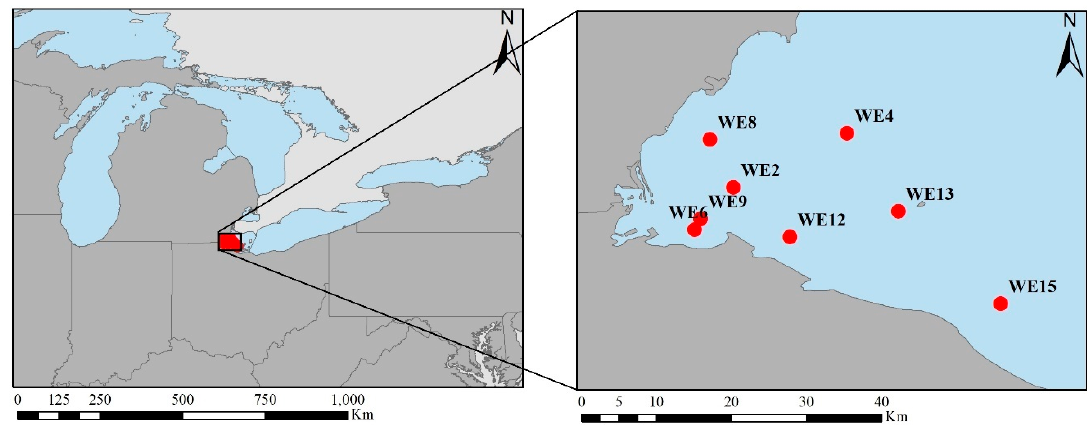
Figure 1. Sampling locations from the Great Lakes Environmental Research Laboratory / Cooperative Institute for Great Lakes Research (GLERL / CIGLR) at the Western region of Lake Erie, U.S.A.